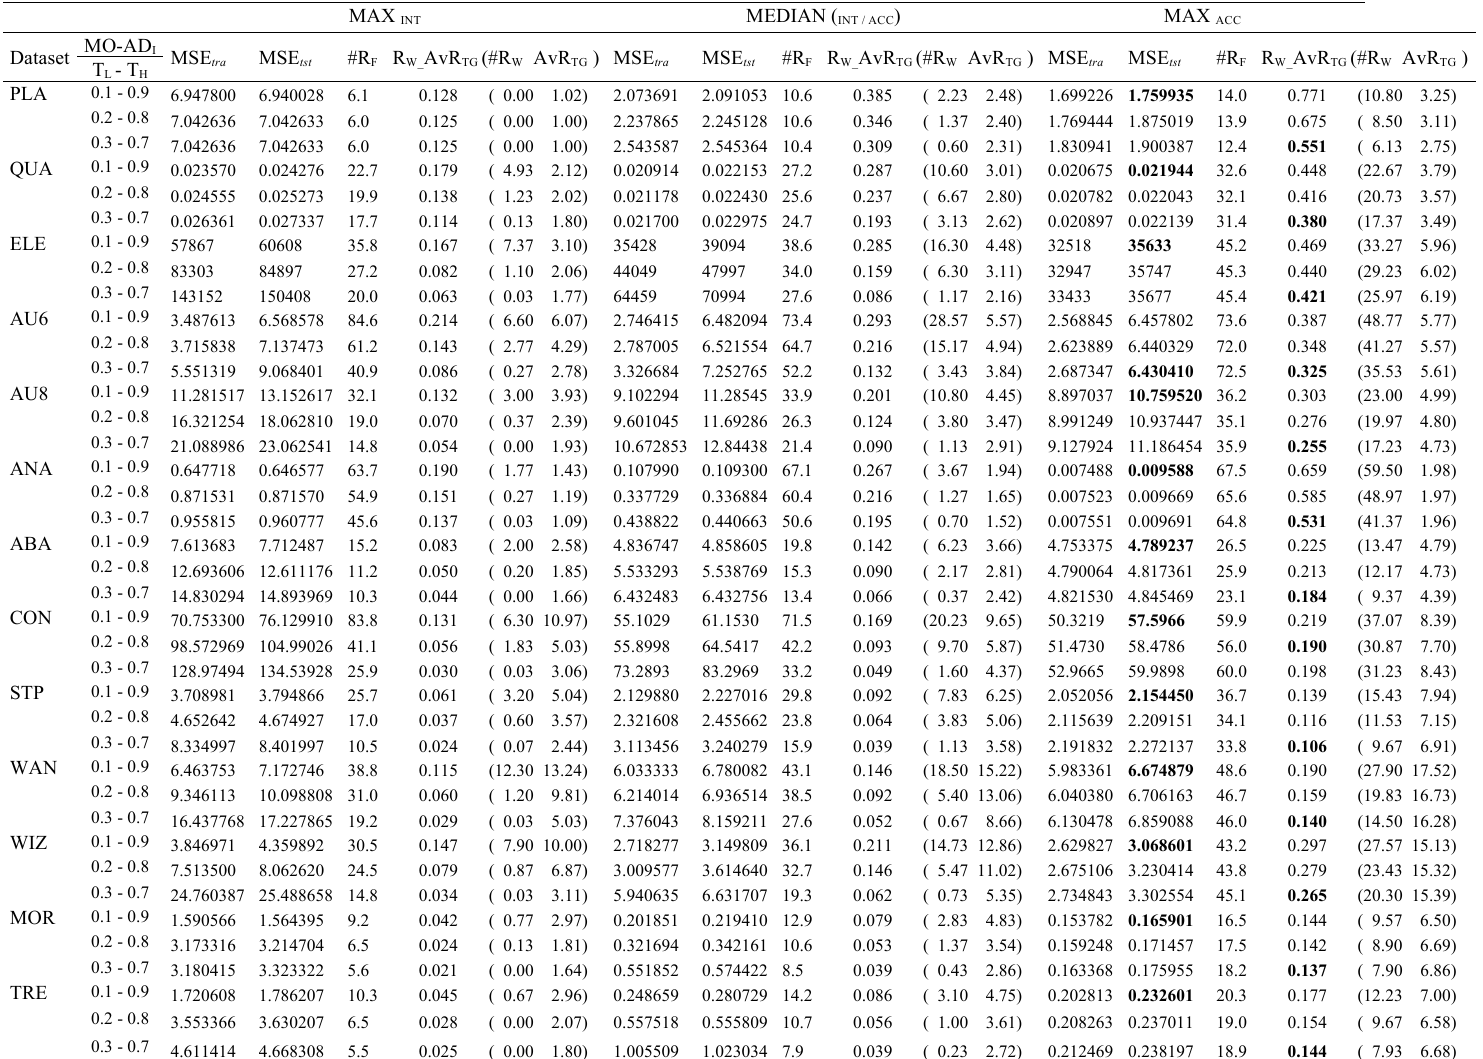
Table 5. Results obtained by MO-AD I for different configurations of thresholds using the WM rule base MAX